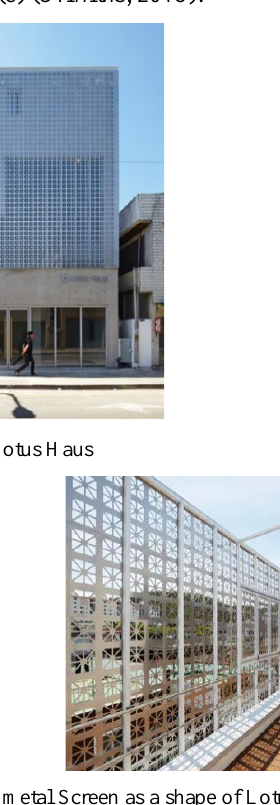
Fig 9(c) The punched metal Screen as a shape of Lotus Flower [Egyptian Mashrabiah]